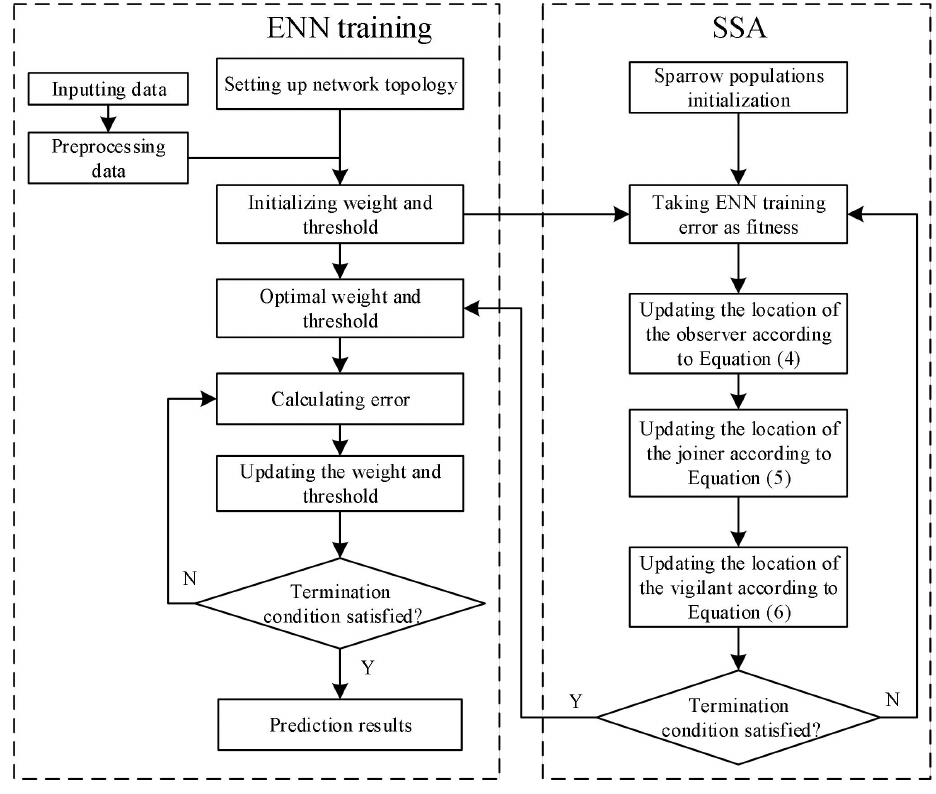
Figure 4. Flow of SSA-ELMAN model.